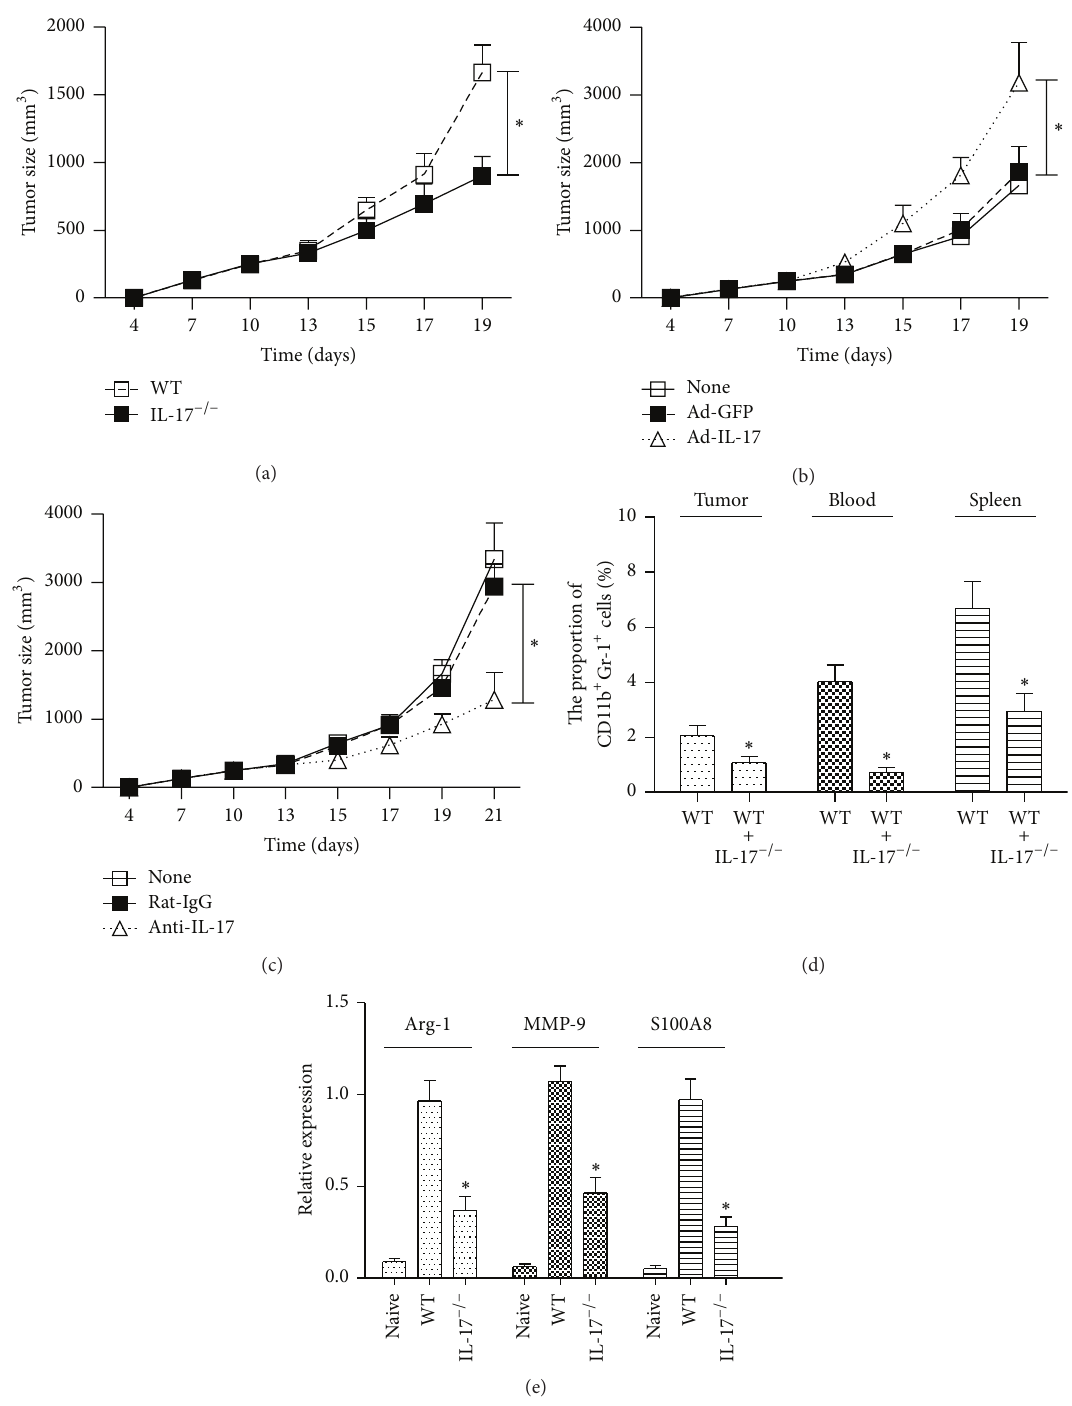
Figure 1: A defect in IL-17 inhibits tumor development. Mice were inoculated s.c. with tumor cells, and tumor sizes were monitored. (a) Wild-type mice and IL-17 −/− mice were inoculated with B16-F10 tumor cells ( 𝑛 = 5 ). (b) Wild-type mice were treated i.v. with Ad-IL-17 or Ad-GFP (10 9 PFU/mouse) or left untreated (none). Two days later, the mice were inoculated with B16-F10 tumor cells, and tumor growth was monitored ( 𝑛 = 5 ). (c) Wild-type mice were inoculated with B16-F10 tumor cells and injected i.p. with normal rat-IgG or a rat anti-mouse IL-17mAb (100 𝜇 g/mouse) on days 0, 1, 6, 10, and 14 ( 𝑛 = 5 ). Control mice were left untreated (none). (d) CD11b + Gr-1 + MDSCs in the spleen, blood, and tumor samples from tumor-bearing mice inoculated with B16-F10 tumor cell 2 weeks ago were analyzed by FACS ( 𝑛 = 5 ). (e) MDSCs were purified from spleens of B16 tumor-bearing mice and stimulated overnight with LPS. CD11b + cells from na¨ıve tumor-free mice were treated with LPS and served as controls. mRNA levels were determined by realtime RT-PCR and normalized to 𝛽 -actin in each sample ( 𝑛 = 5 ). The data show means ± SEM of tumor size and are representative of three independent experiments. ∗ 𝑃 < 0.05